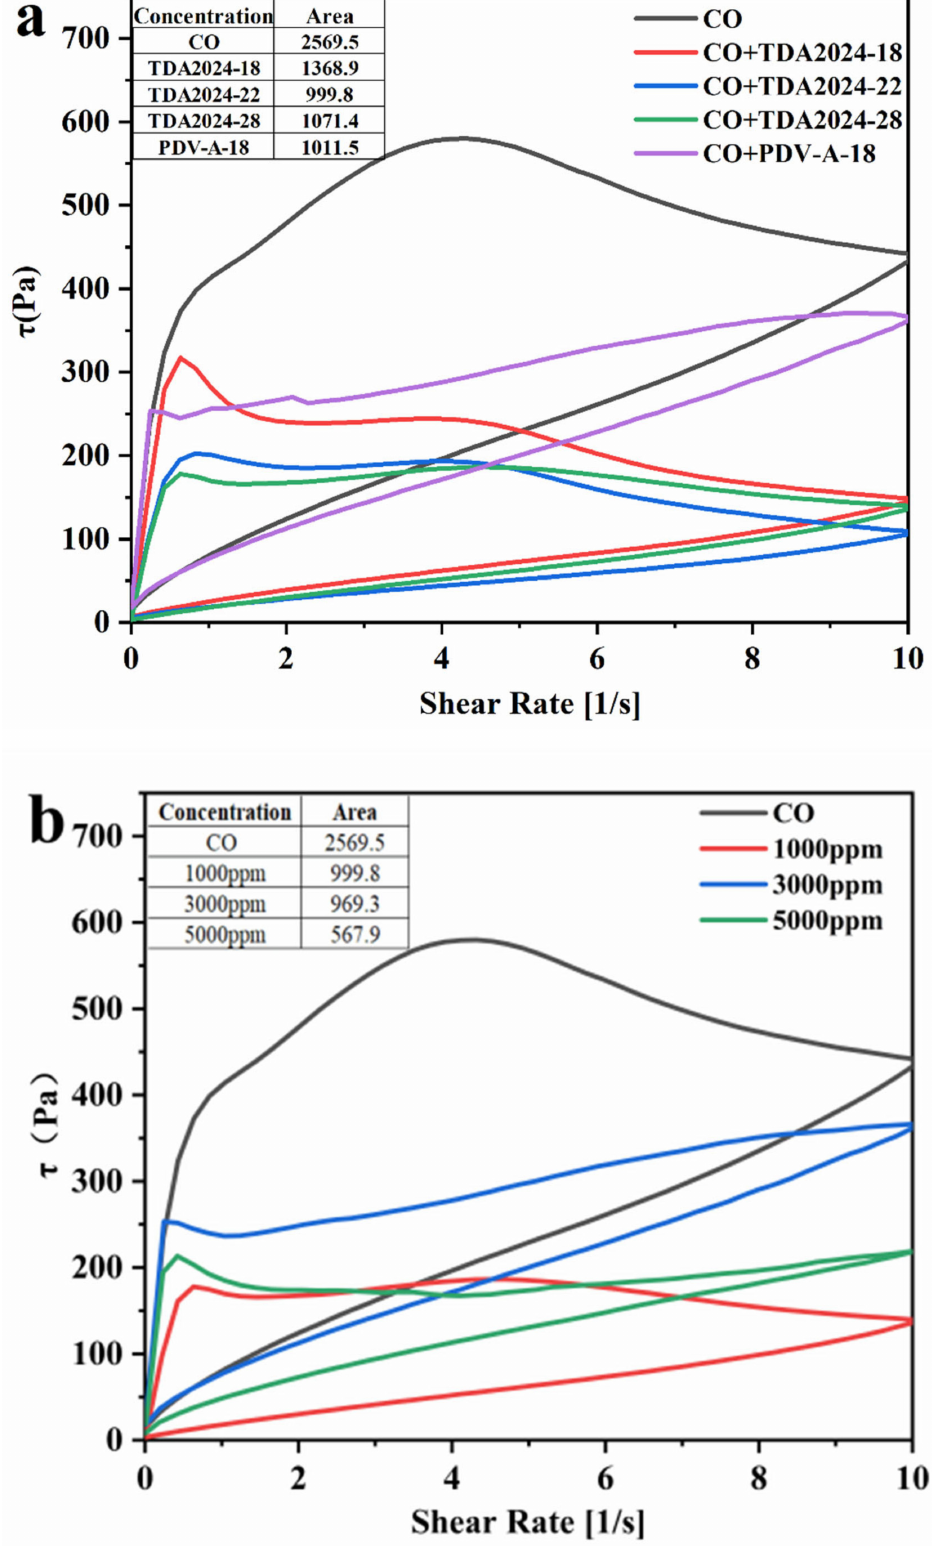
Figure 12. Thixotropy of African crude oil in the presence of ( a ) different bipolymers at 1000 ppm, and ( b ) TDA2024-22 at varying